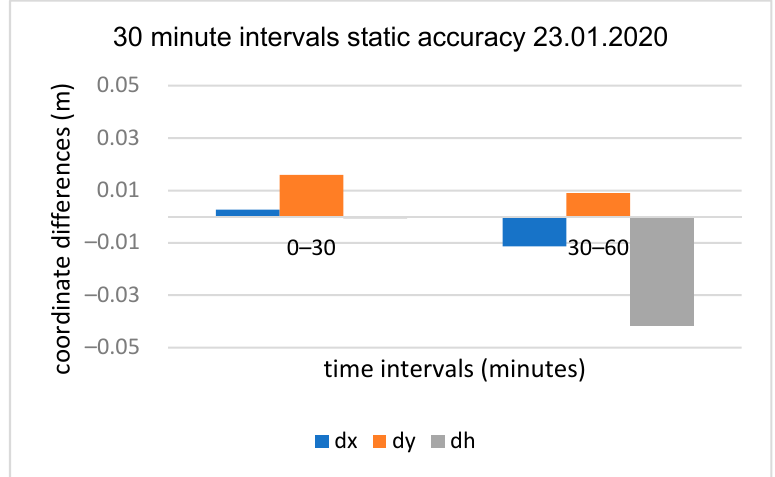
Figure 20. 30 min sub-session positioning results for the third test, baseline OPNT–P30Pro (4 km).